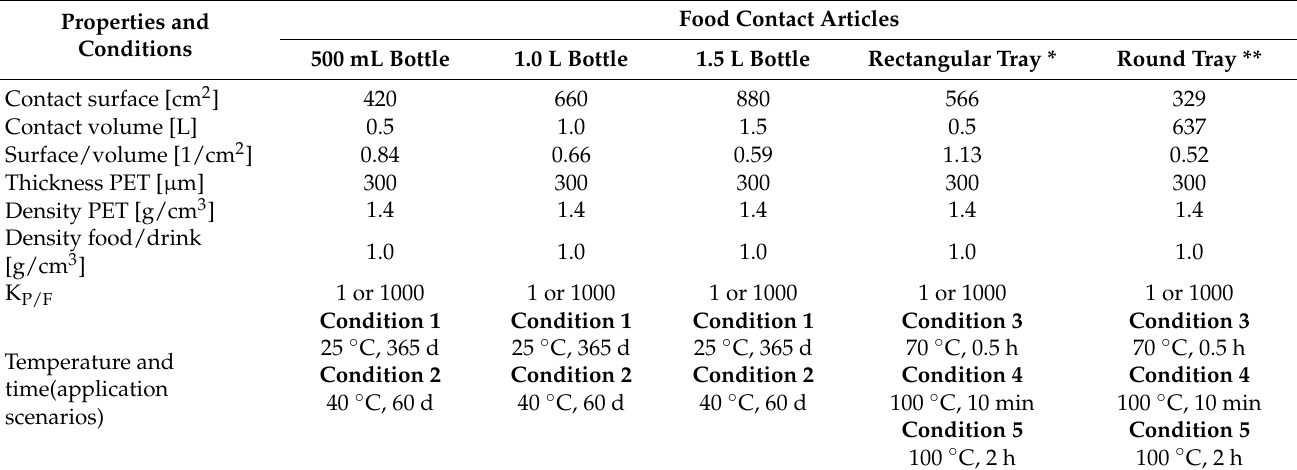
Table 4. Properties and parameters used for migration modeling for different food contact